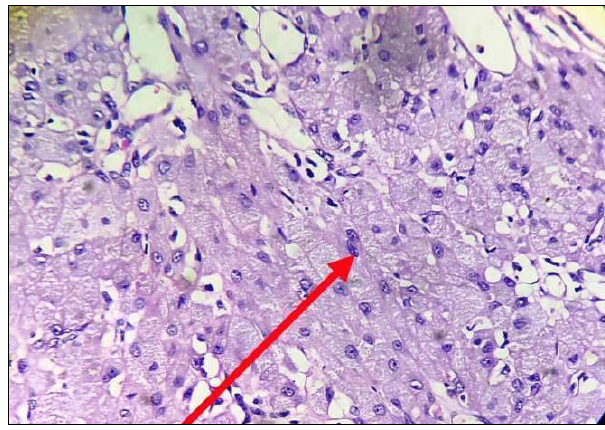
Figure 3: Histopathology slide showing abundant coarse granular, eosinophilic cytoplasm with vesicular nuclei [40X magnification, H & E staining]